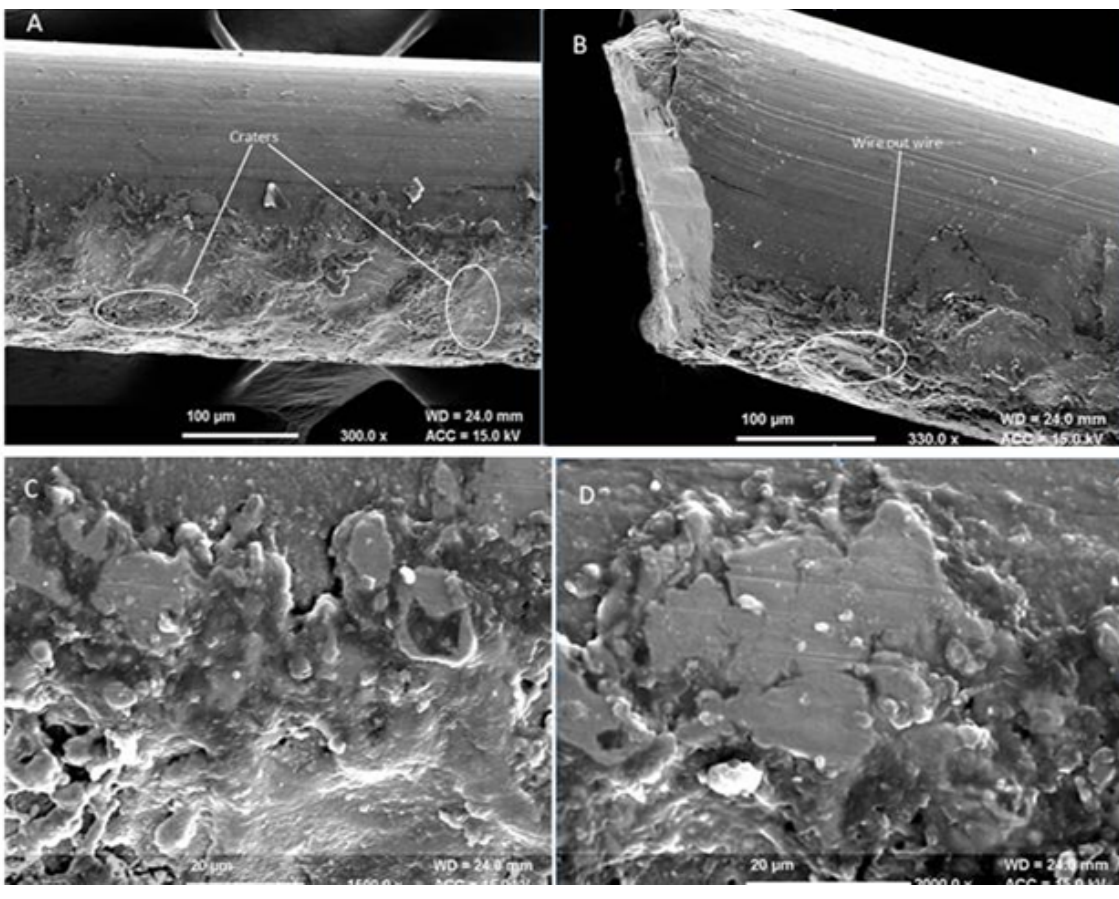
Figure 10: Scanning electron micrographs of work material for WWR Table 7: Validation of predicted